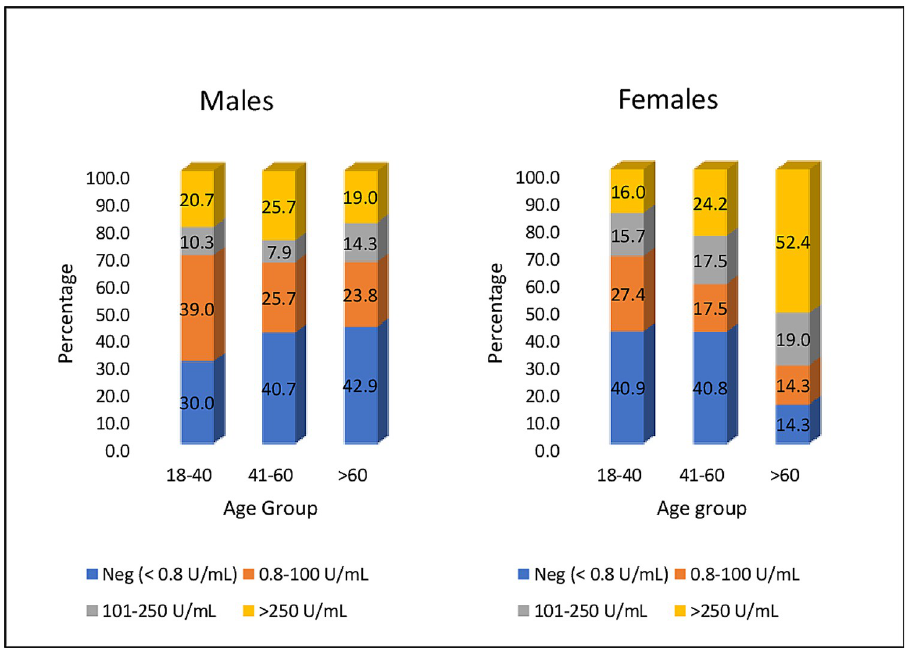
Fig 1. Age and gender distribution of antibody titre.